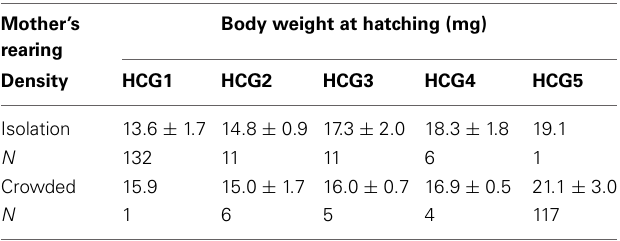
Hatchlings in HCG 1 are green as typically observed in solitarious phase and